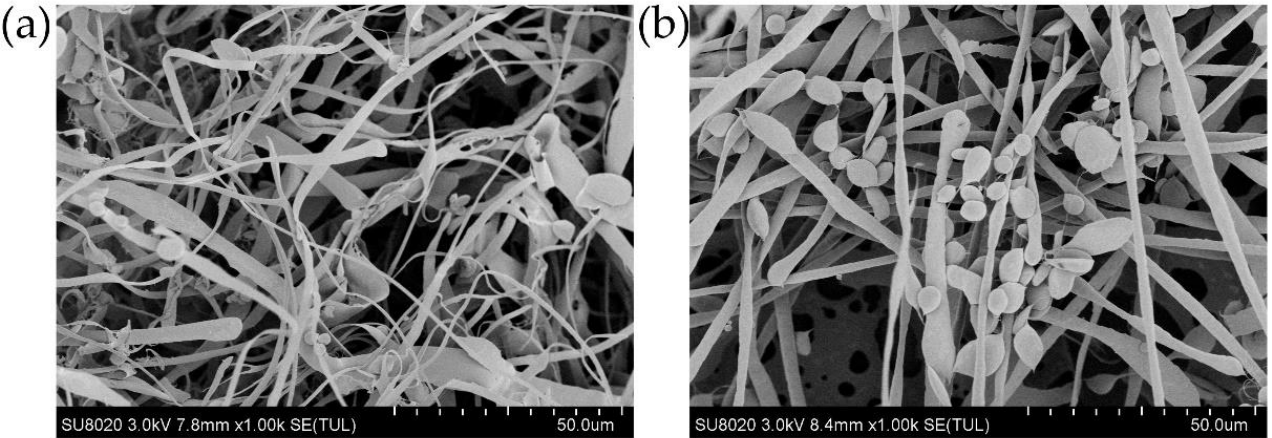
Figure 4. Scanning electron microscopy for ( a ) water-insoluble β -glucan and ( b ) water-soluble β -glucan.